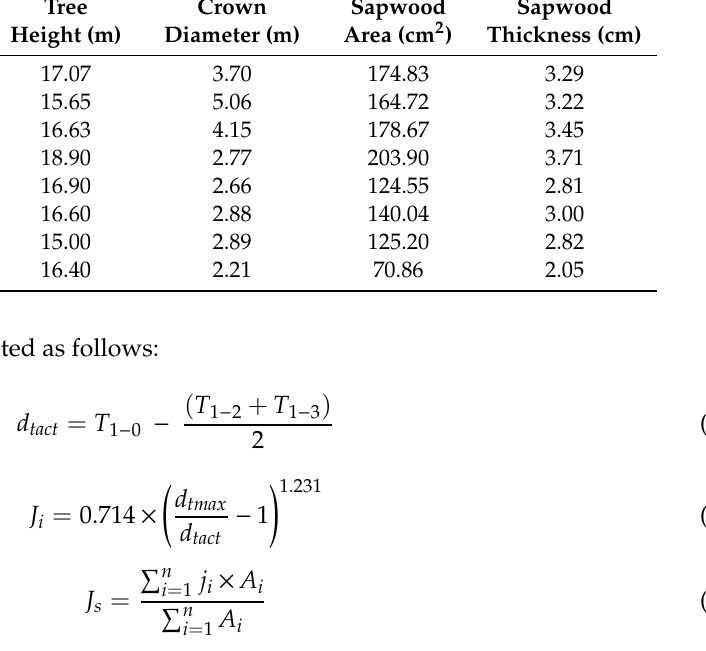
Table 1. Characteristics of the eight sample trees of Larix principis-rupprechtii Mayr for sap flux density measurements. Tree No. DBH (cm)